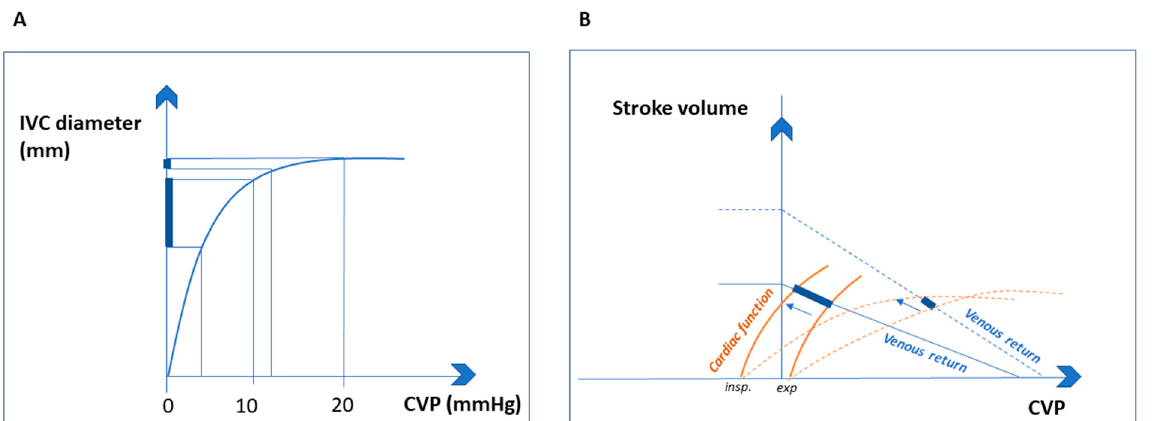
Figure 2. Inferior vena cava diameter as a function of residual venous compliance ( A ). In the initial ascending part, a small variation in CVP significantly increases IVC diameter. In the second part, IVC compliance decreases and a larger increase in CVP causes minimal IVC dilation. Modified from [9,15]. Inferior vena cava diameter as a function of cardiac functional reserve ( B ). The intersection between the venous return and cardiac function curves is shown for subjects with normal (solid lines) and impaired cardiac function (dotted lines). Only when cardiac function is preserved can inspiration shift the cardiac function curve to the left with CVP reduction and IVC collapse. Modified from [14]. (CVP: central venous pressure, IVC: inferior vena cava).